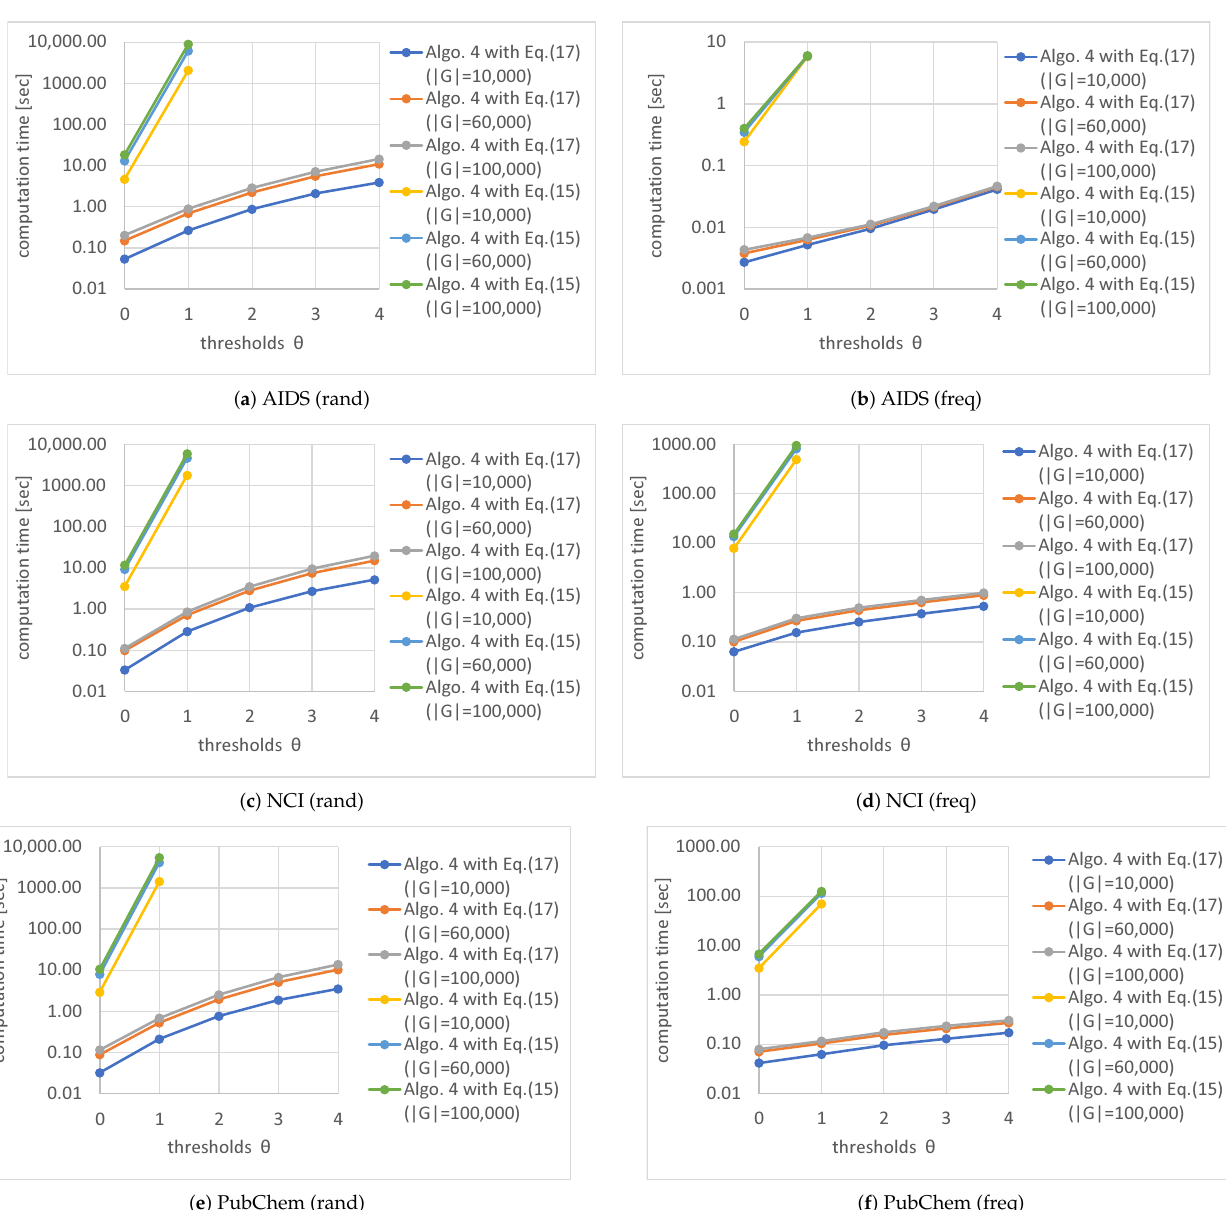
Figure 15. Computation times of Algorithm 4 with Equation (15) and Equation (17) for various numbers of graphs | G | in a database and various thresholds θ